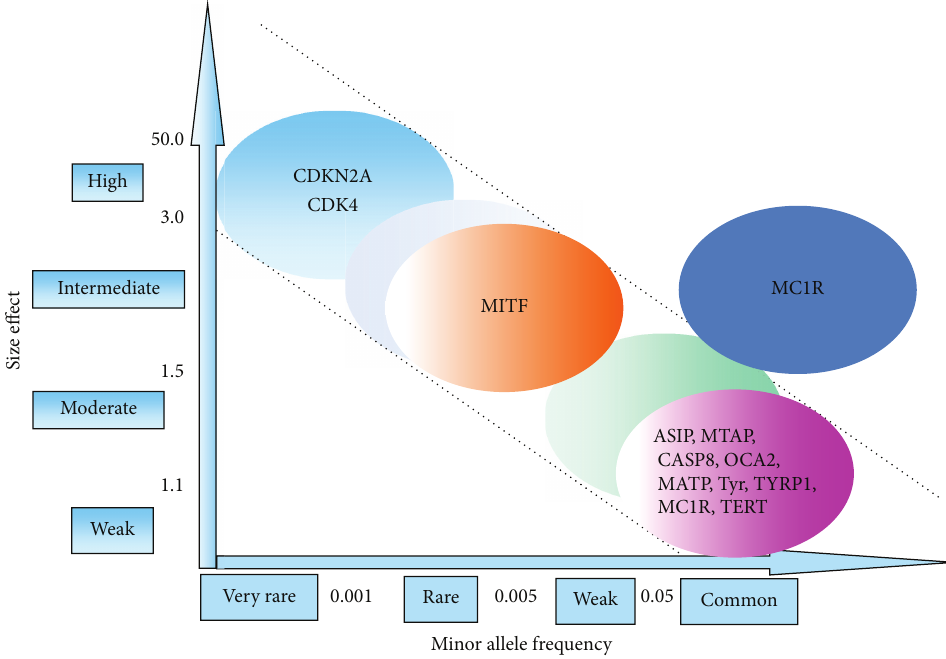
Figure 2: Melanoma susceptibility alleles (adapted from Manolio et